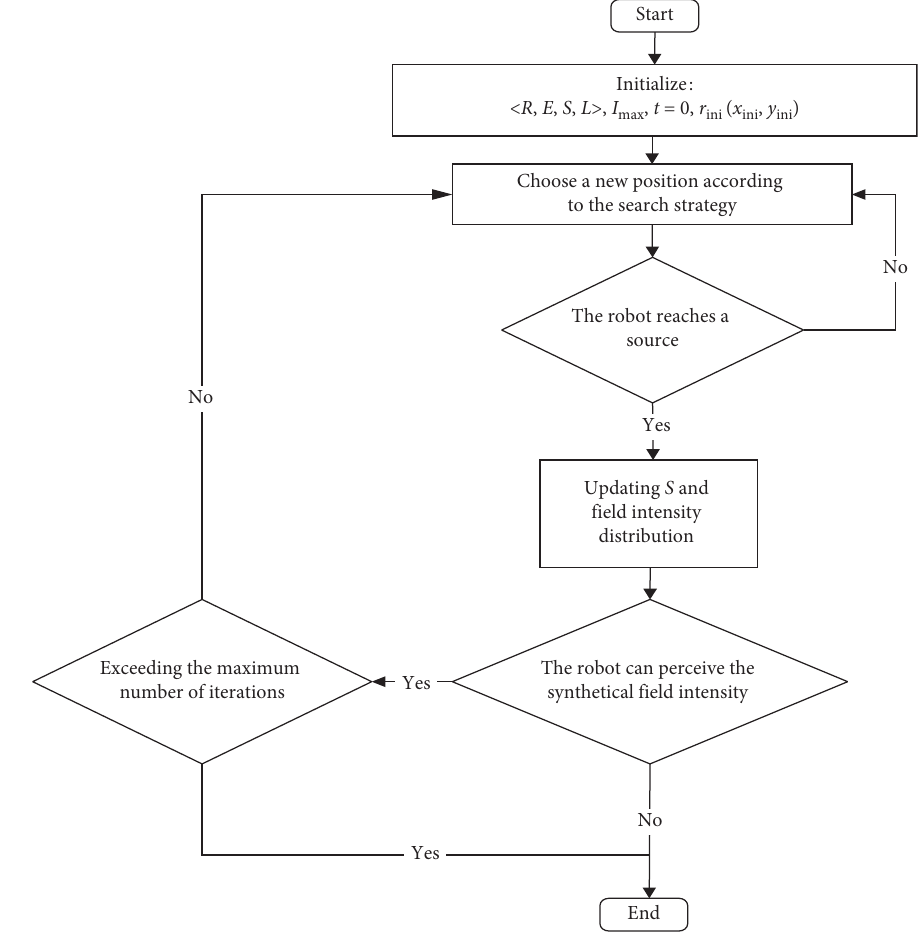
Figure 2: The flowchart of source search based on